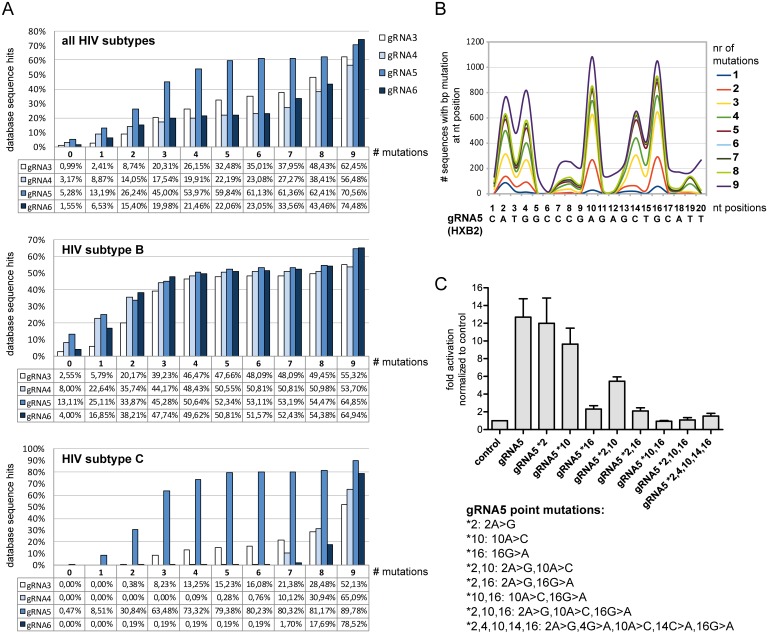
Conservation of optimal gRNAs and the effect of sequence variation on SAM-mediated LTR activation.(A) Sequence conservation of HXB2-derived gRNA3, -4, -5 and -6 based on the Los Alamos HIV Sequence Database considering all HIV subtypes (upper panel), subtype B only (middle panel) or subtype C only (lower panel). Percentages of sequence hits are shown, allowing for 0 to 9 point mutations in the indicated gRNA (see Materials and Methods for details). (B) Frequency distribution of gRNA5 mutations observed in database hits according to nucleotide (nt) position. Different colors indicate the number of mutations (1–9). (C) The effect of sequence variations in gRNA5 on SAM-mediated LTR activation was tested by transient expression of gRNA mutants (gRNA *X, where X is the mutated nucleotide position) with SAM system components in TZM-bl cells. Activation levels were measured at 48 h post transfection by luciferase assays performed on whole cell lysates. Activation is shown as fold increase (light units/transfected cell) over negative control (no gRNA expression). Shown are results of two independent experiments.